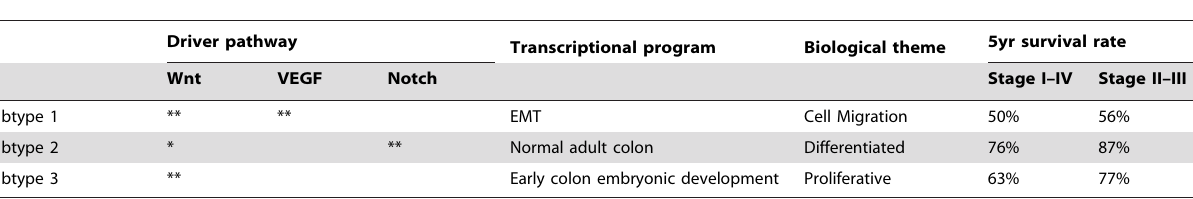
Table 3. Distinct mechanisms driving unique cancer biology and clinical outcome in different transcriptional subtypes.